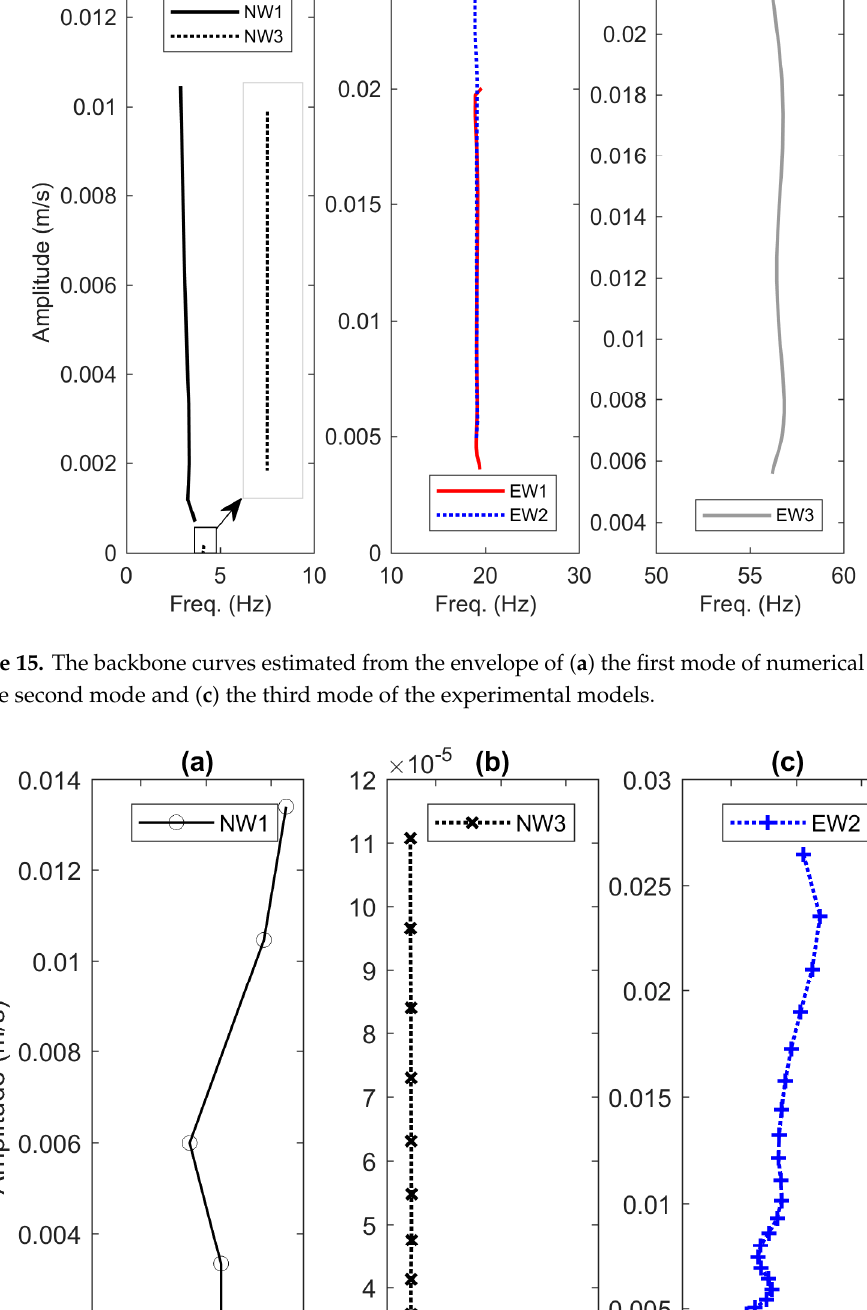
Figure 14. Time series of frequency.